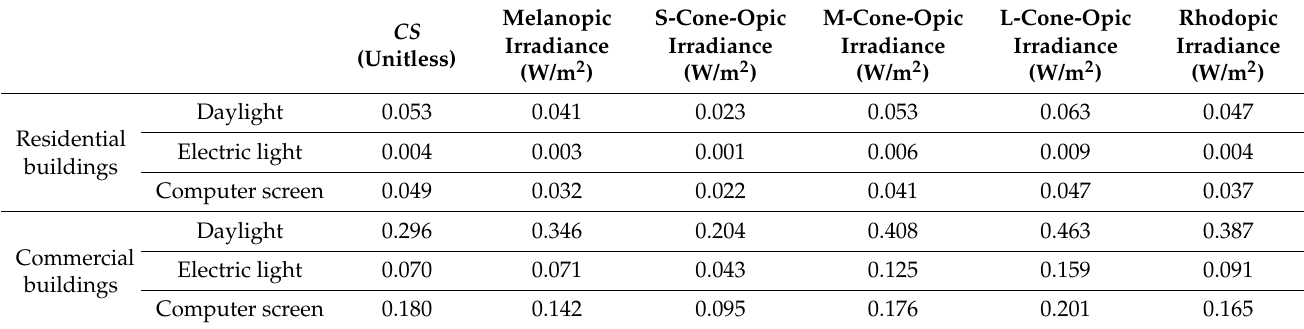
Table 1. The average α -opic irradiance and circadian stimulus ( CS ) for daylight, electric lighting, and light from displays in home offices in residential buildings and offices in commercial buildings, as measured at the eye